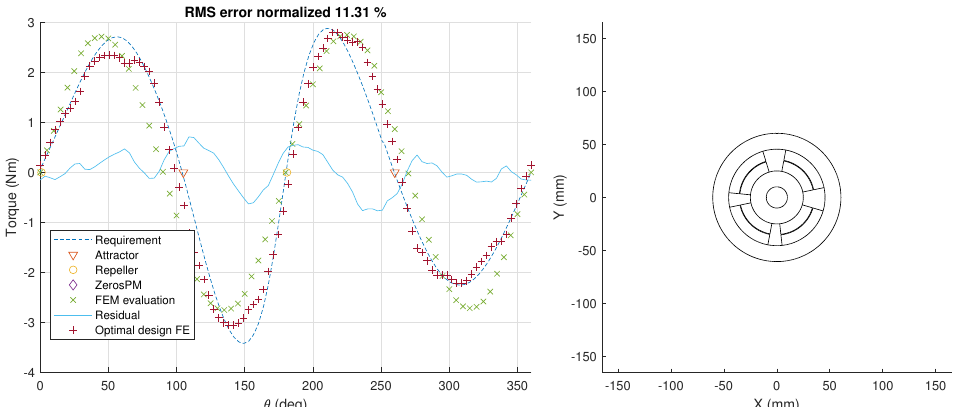
Figure 6. Extended parametrization approach, optimization results for 4 bar linkage reference torque. Left —FEM torque characteristic calculation, right —initial magnetic spring geometry.